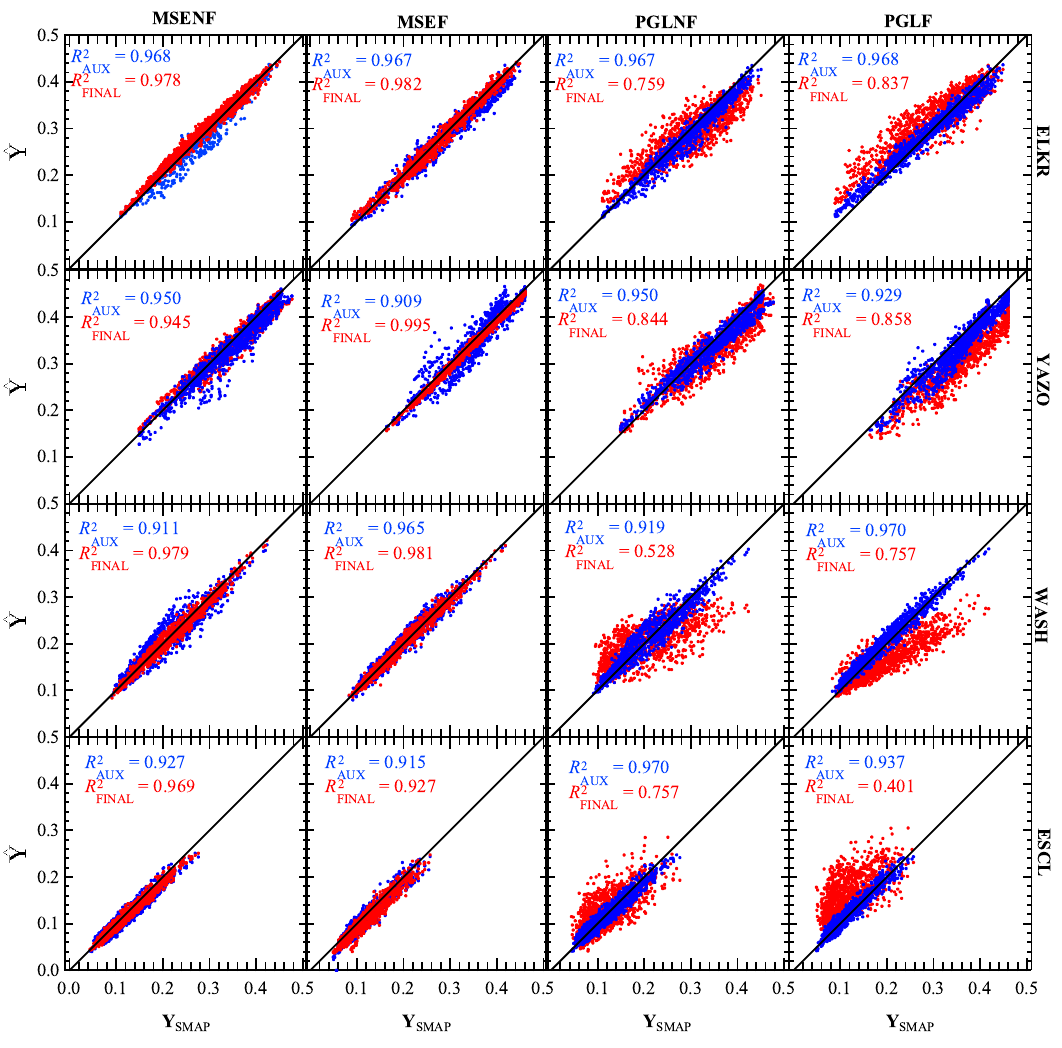
Figure 6. Results for MULTT experiments trained and tested on all four watersheds during the TIME_E period (1 January 2016–31 December 2018). The rows show results for each study site (from top): ELKR, YAZO, WASH, ESCL. The columns are (from left): MULTT_MSENF, MULTT_MSEF, MULTT_PGLNF, MULTT_PGLF. Results for ˆ Y AUX vs. Y SMAP are shown in blue, and ˆ Y FINAL vs. Y SMAP are shown in red. The output with the highest accuracy is shown as the top layer in each subplot, highlighting the effectiveness of each loss